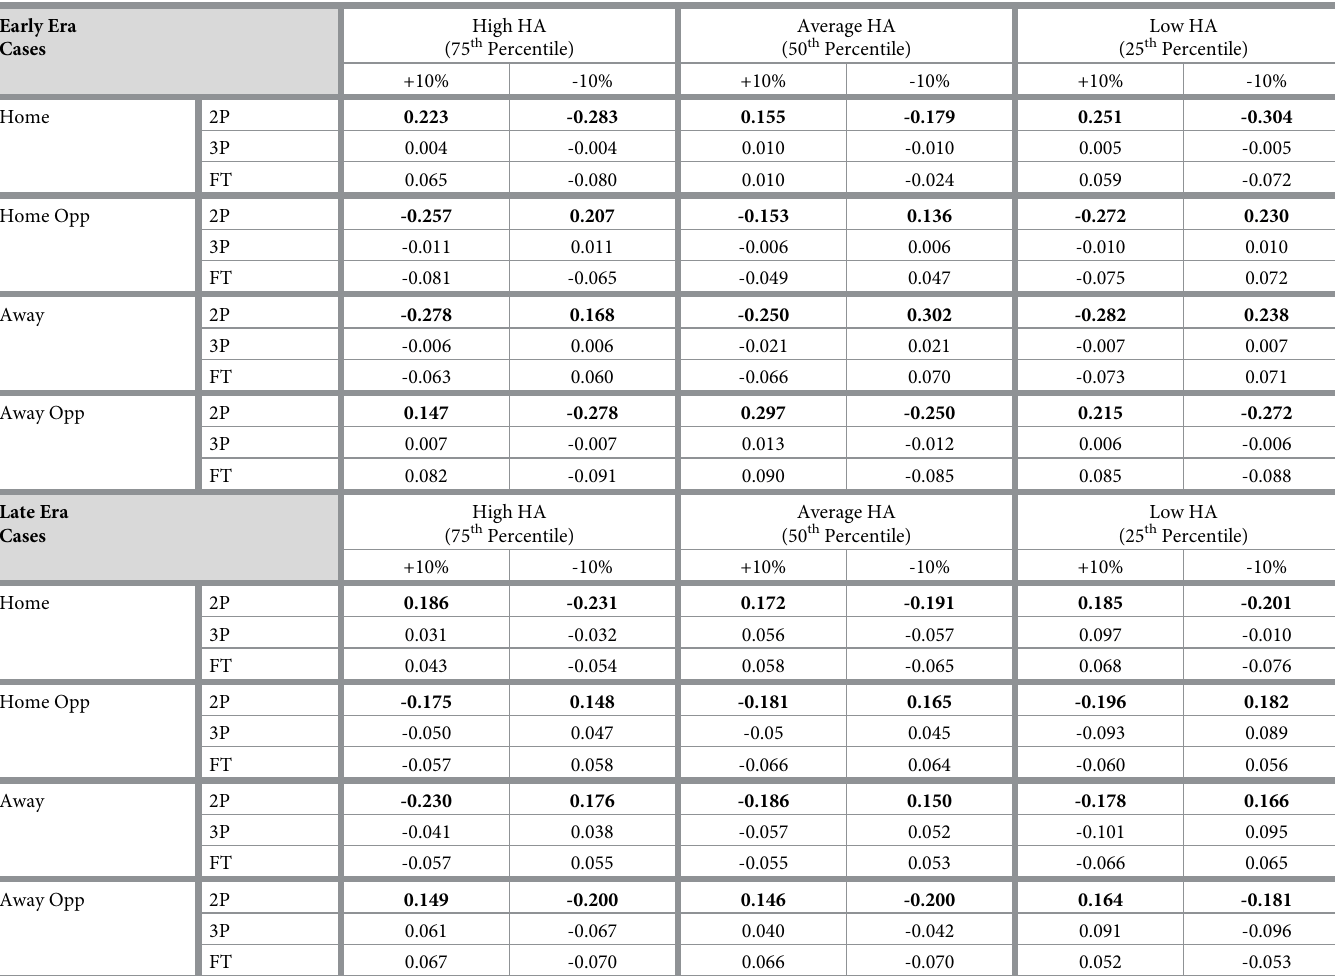
Table 2. ANN sensitivity analysis.